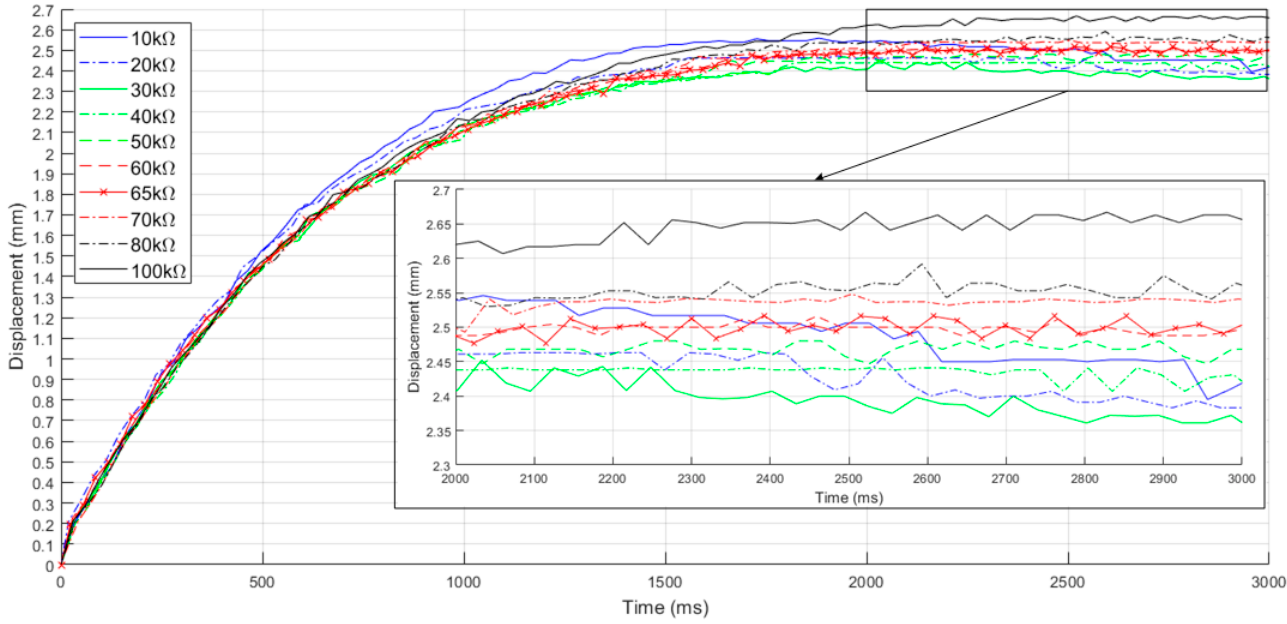
Figure 9. Absolute values of displacements of point No. 10 for 10 values of resistance. In the third stage, average displacements of nine points were calculated for the time range from 2000 ms to 3000 ms. A comparison of the average displacements of 10 points in the beam structure for 10 values of resistance is presented in Figure 10.